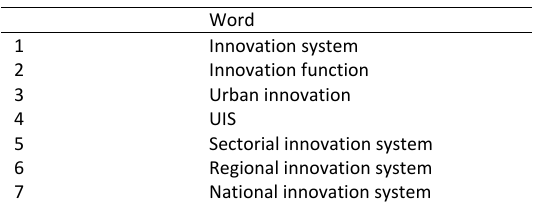
Table 2: The key terms of UIS